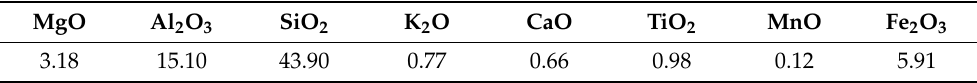
Table 1. XRF chemical compositions (wt%) of raw VK.